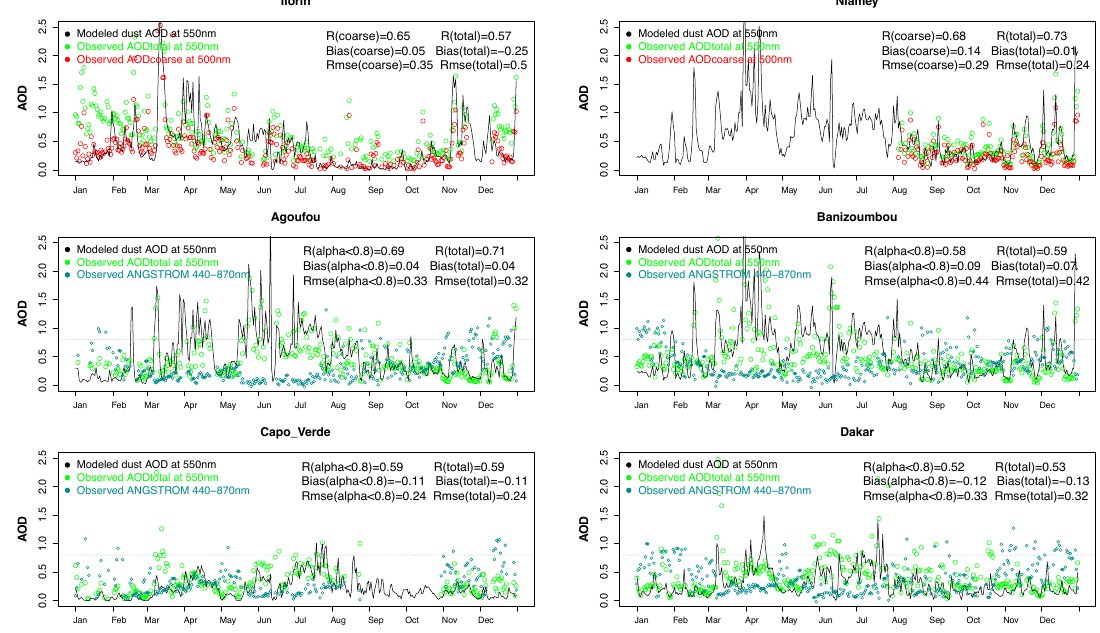
Fig. 5. Daily AOD average of model vs. AERONET stations in the Sahel and Western Africa for 2006. Model averages (black lines) represent the dust AOD at 550 nm. In the upper panels, observations at Ilorin and Niamey stations include AODtotal (green circles) and AODcoarse (red circles). Each panel includes the correlation ( R ), bias and root mean square error (RMSE) between the model and AODcoarse and AODtotal. In the middle and lower panels, observations at Agoufou, Banizoumbou, Capo Verde and Dakar include AODtotal (green circles) and ˚Angstr¨om exponent between 440nm and 870nm (blue circles). The top right of each panel includes R , bias and RMSE between the model and the AODtotal for ˚Angstr¨om exponents below 0.8 and AODtotal.